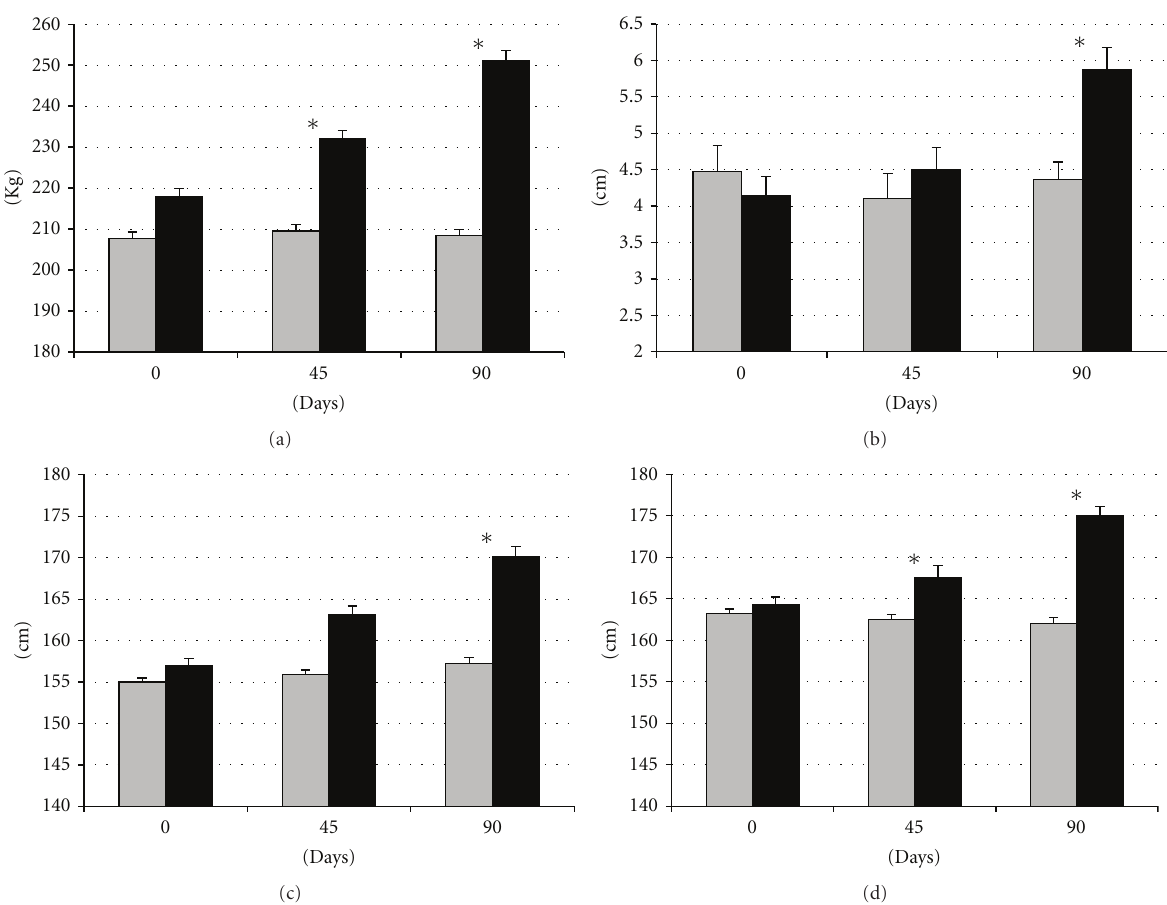
Figure 1: Changes in mean live weight (a), back-fat depth (b), and abdominal and thoracic circumferences ((c) and (d), resp.) over time after di ff erential feeding in control sows (grey bars) and sows with ad libitum access to a diet enriched with saturated fat (black bars). Asterisks indicate significant di ff